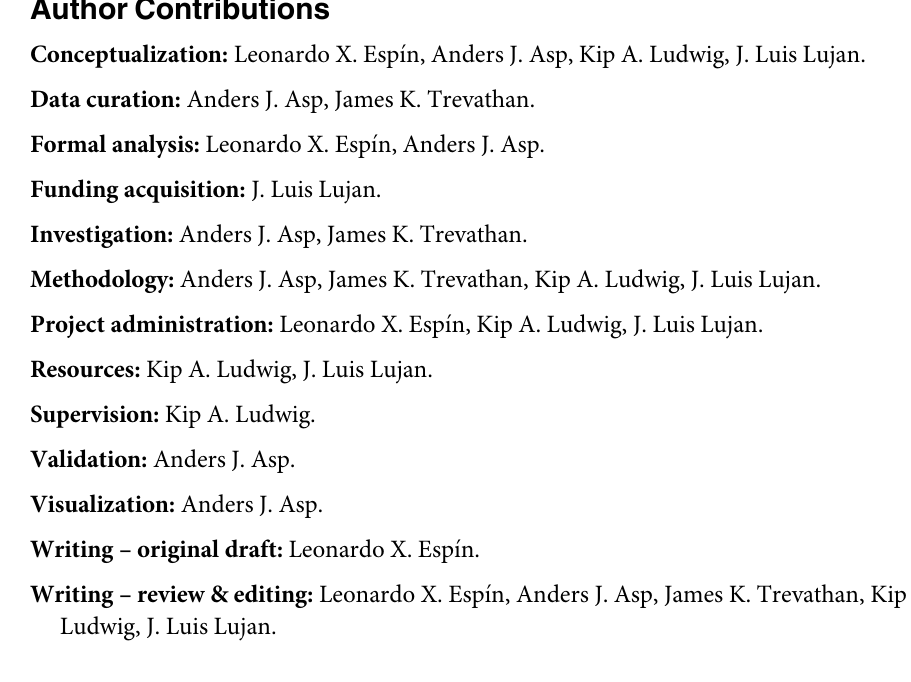
S1 Fig. Linear charge calibration curve for dopamine, adenosine, and dopamine +adeno- sine using a)True integration limits b) curvature integration limits, and c) inflection inte- gration limits at concentrations of 0.1 μ M, 0.5 μ M, and 1 μ M. Data are fit with a linear regression and R 2 values are displayed for each